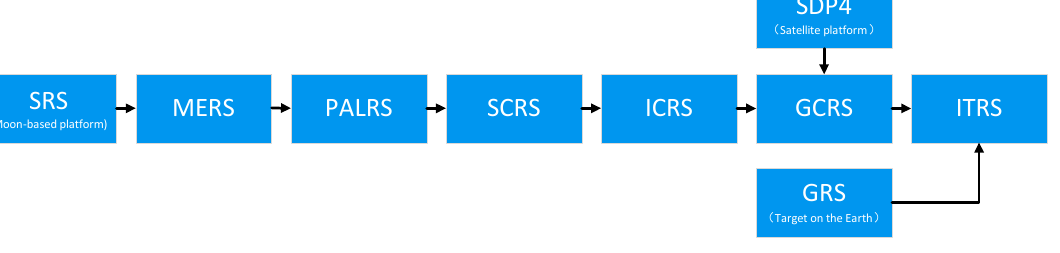
Figure 4. Flowchart of reference systems transformation.